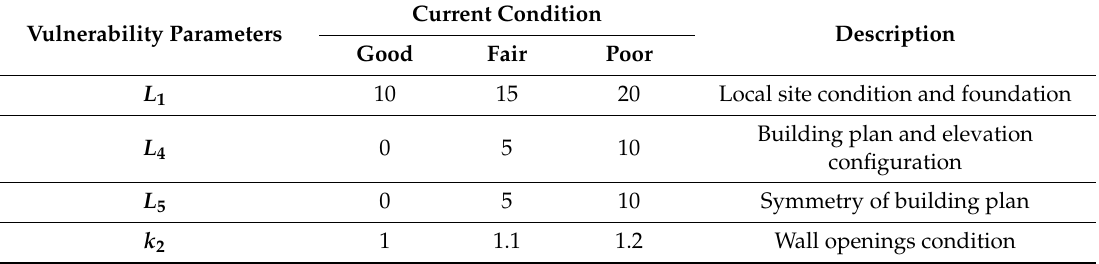
Table 6. Values of parameters L 1 , L 4 , L 5 , and k 2 [8].